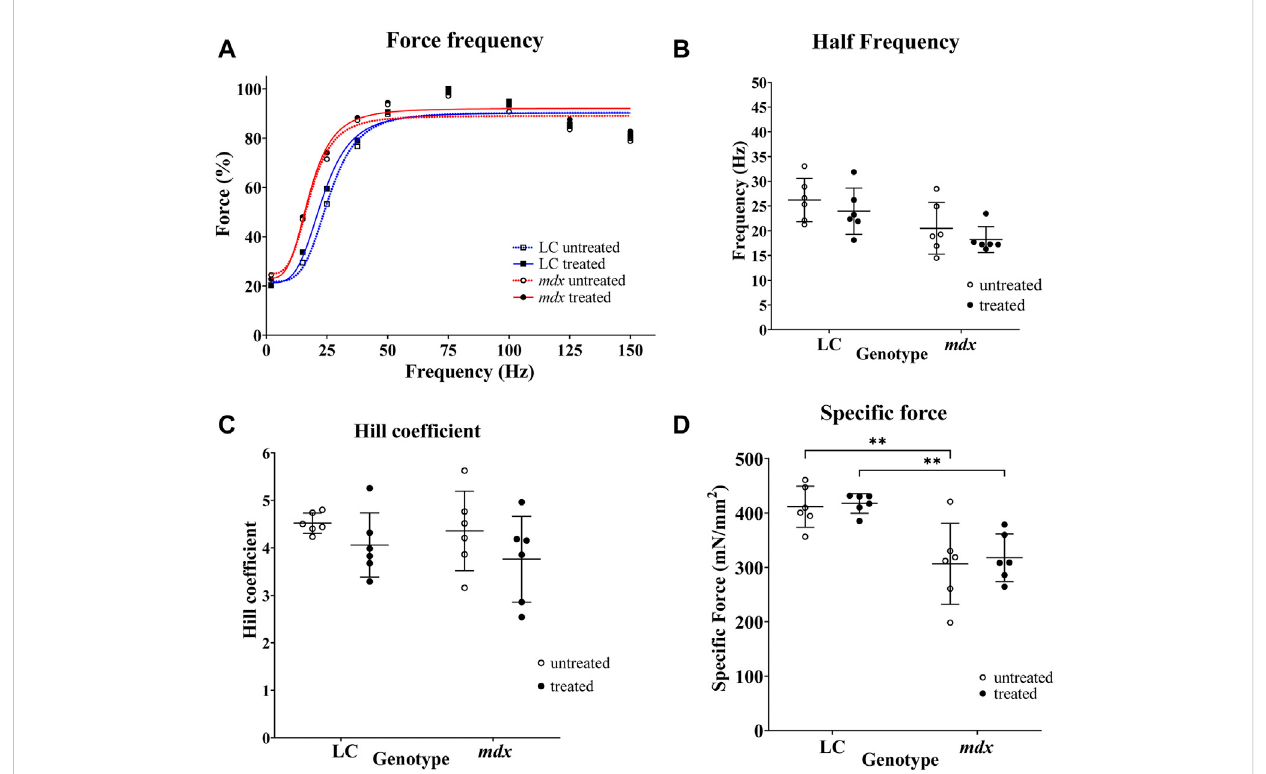
FIGURE 2 Forcefrequencycurvesand fi ttedparametersandspeci fi cforce. (A) ForcefrequencydatafromindividualEDLmuscleswereaggregatedtoproduce asinglecurveforLCandmdxmicetovisualizedifferencesbetweentreatmentgroupsandgenotypes( n =6EDLforeachgroup).Forcesarenormalizedto P max . In graph (A) SD error bars are omitted for clarity. (B,C) are scatterplots of half-frequency and Hill coef fi cient obtained from force frequency curve shownin (A) . (D) Showsthemaximumspeci fi cforce(Po)producedbytheEDLmuscles,therewasnoeffectofNACtreatment,however,ashasbeen reported previously the dystrophin de fi cient mdx muscles produced signi fi cantly less force than LCs, both in NAC treated ( p = 0.0035) and untreated (0.0023) conditions. Data set represent mean value